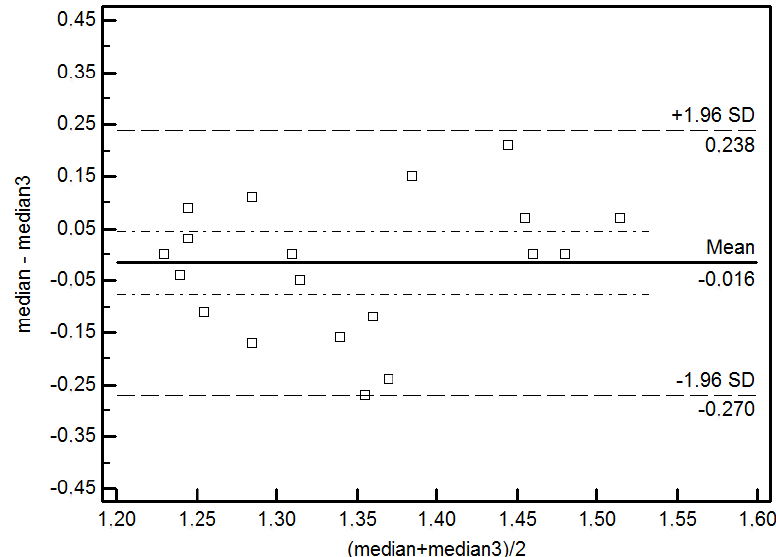
Figure 2. Bland-Altman analysis of the reproducibility of LDPI measurements under different experimental conditions. Bias is represented by the solid line (–0.016). The two dotted lines represent the limits of agreement for reproducibility (–0.270;